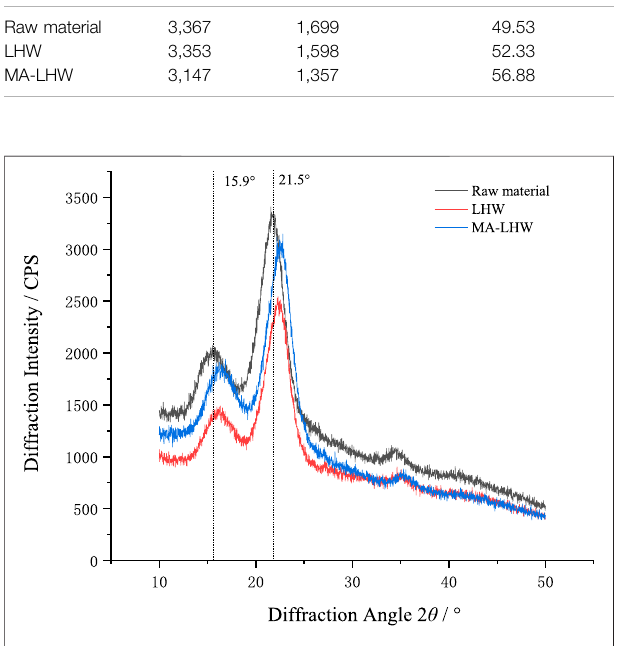
FIGURE1| Thex-raydiffraction spectraofMoso bamboo pretreated by different